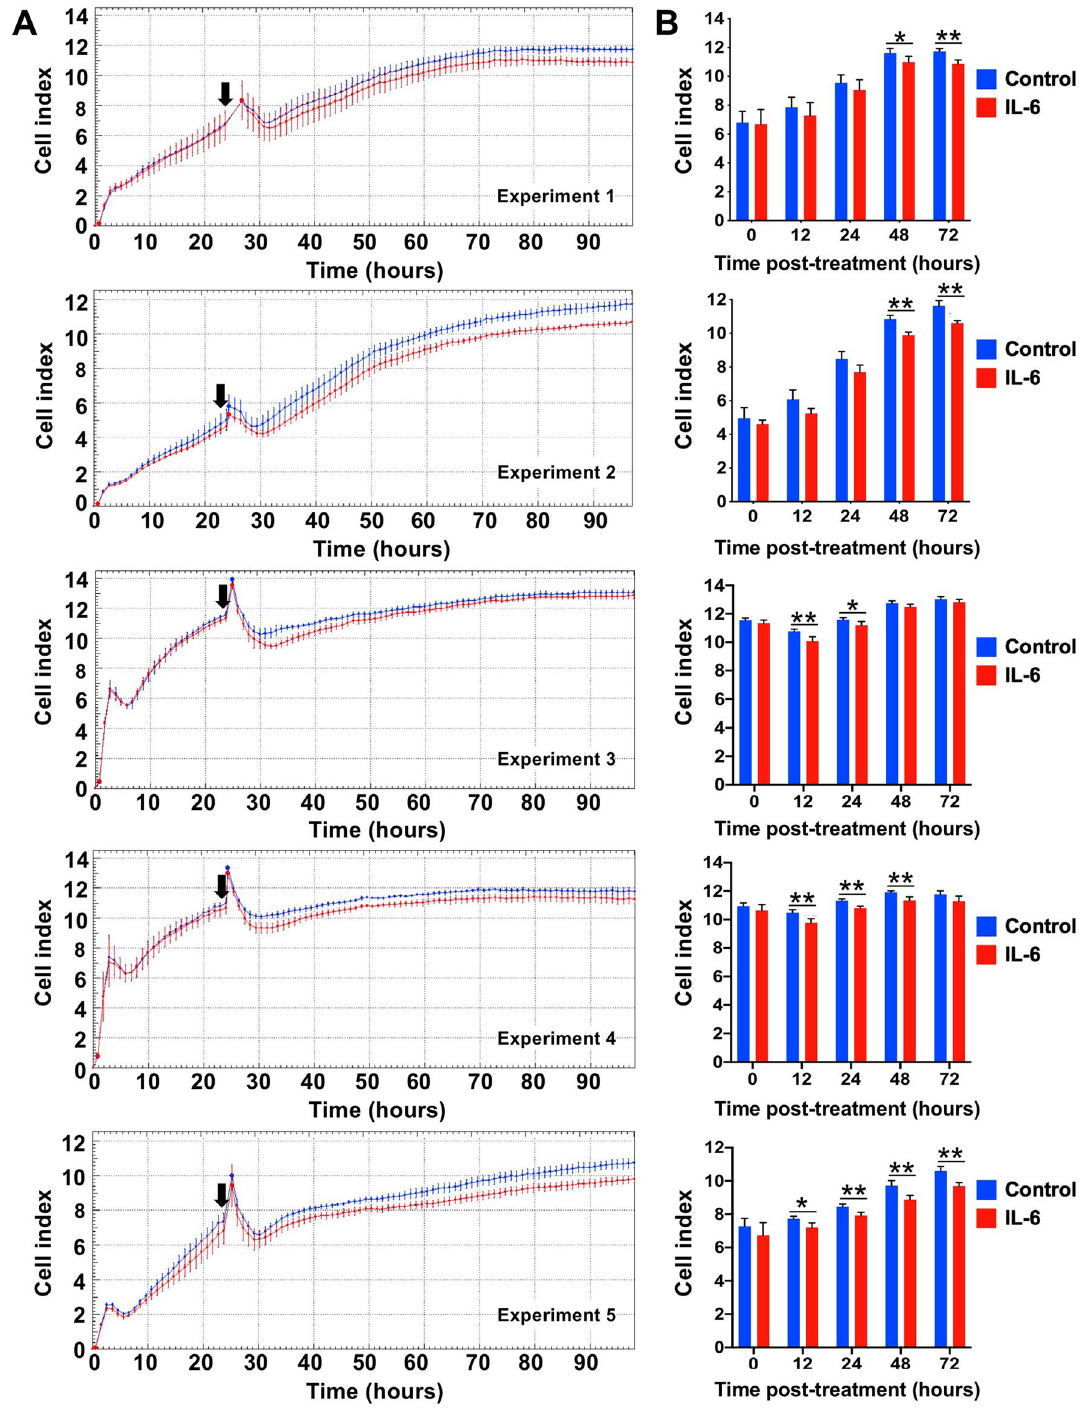
Fig. 3 Effect of IL-6 on permeability of human retinal endothelial cell monolayers. Results were generated in 5 independent experiments using the expanded cell isolate. A Plots of transcellular electrical resistance across IL-6-treated (red) versus untreated control (blue) cell monolayers, measured as cell index each hour. Arrowheads mark time of IL-6 treatment. Dots represent mean, with error bars indicating standard deviation. n monolayers per condition. B Graphs showing cell index at specified time intervals following IL-6 treatment for corresponding experiments. Bars represent mean, with error bars showing standard deviation. n 3–4 monolayers per condition. Groups were compared by 2-tailed Student’s t-test: = * p < 0.05; ** p = = ≤